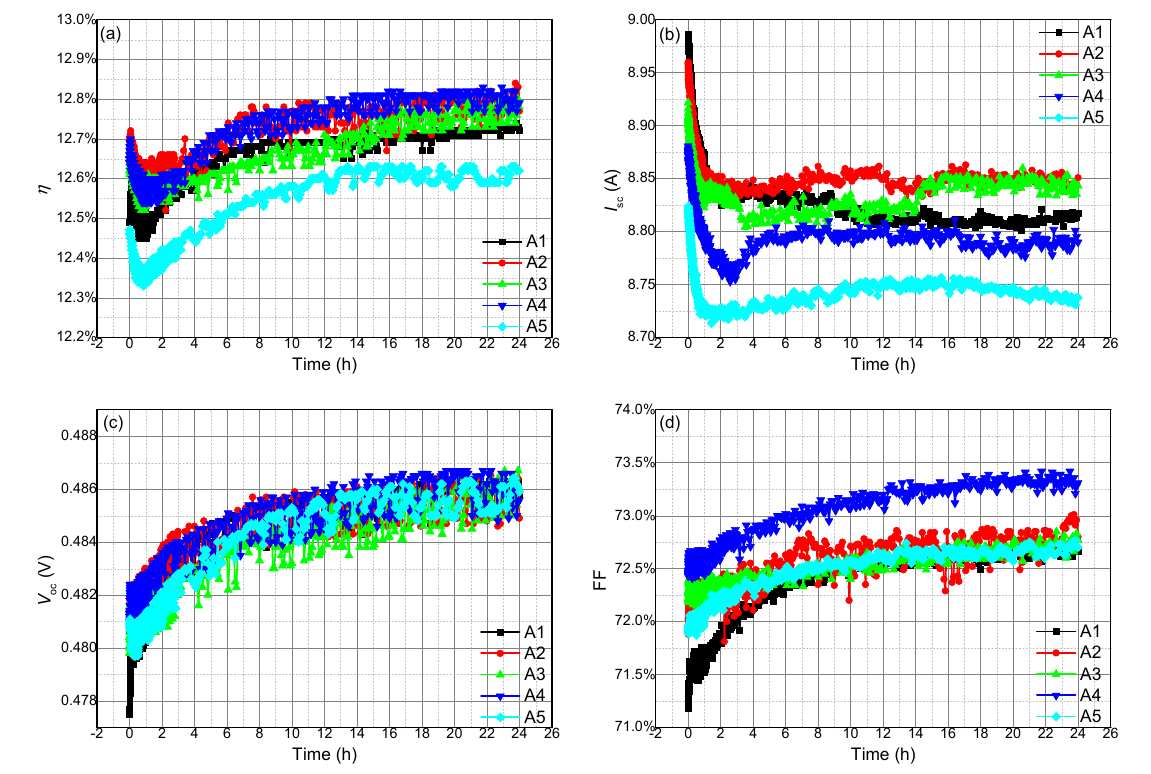
Figure 2. In-situ changes of illuminated I - V characteristic parameters of five groups of Al-BSF solar cells with processing time within the regeneration (100 °C, 1 sun, 24 h). ( a ) efficiency; ( b ) short- circuit current; ( c ) open-circuit voltage; ( d ) fill factor.